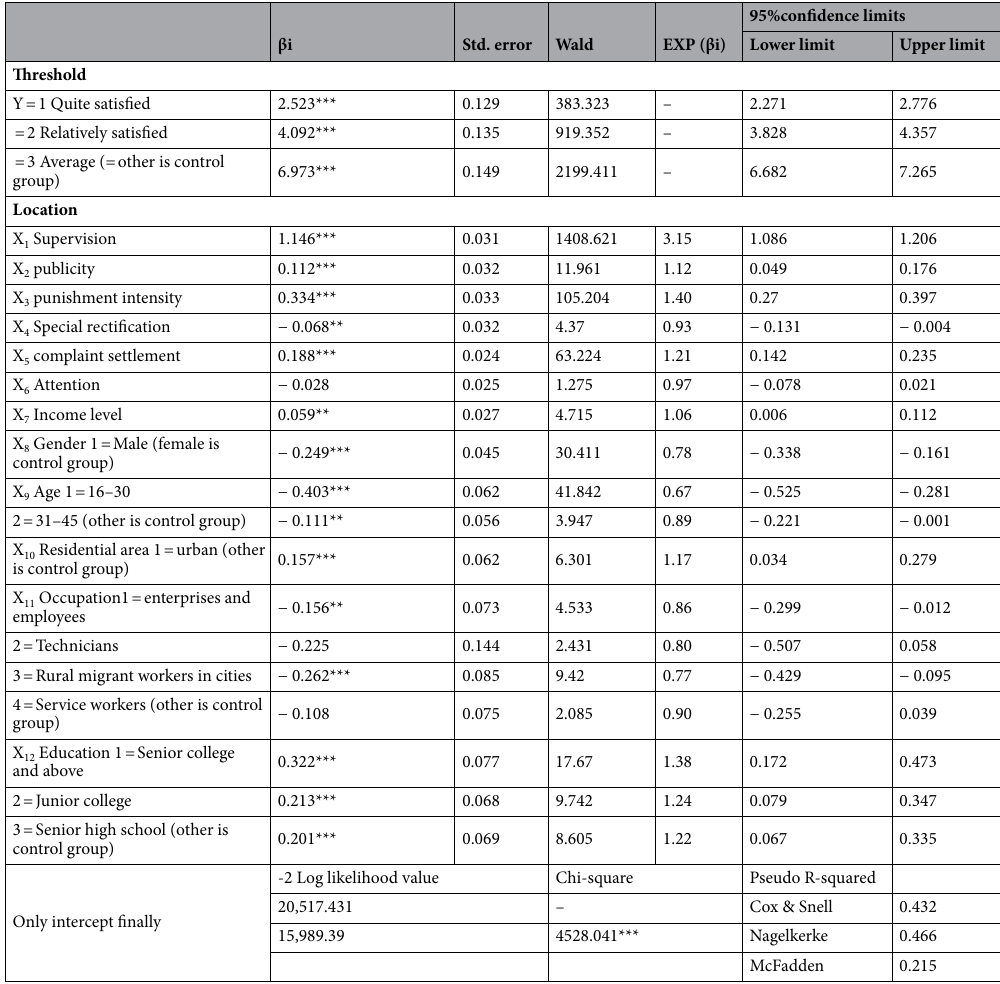
Table 7. Model (5) parameter estimation. Note: *** P < 0.01, ** P < 0.05, * P < 0.1, the same below. Link function: